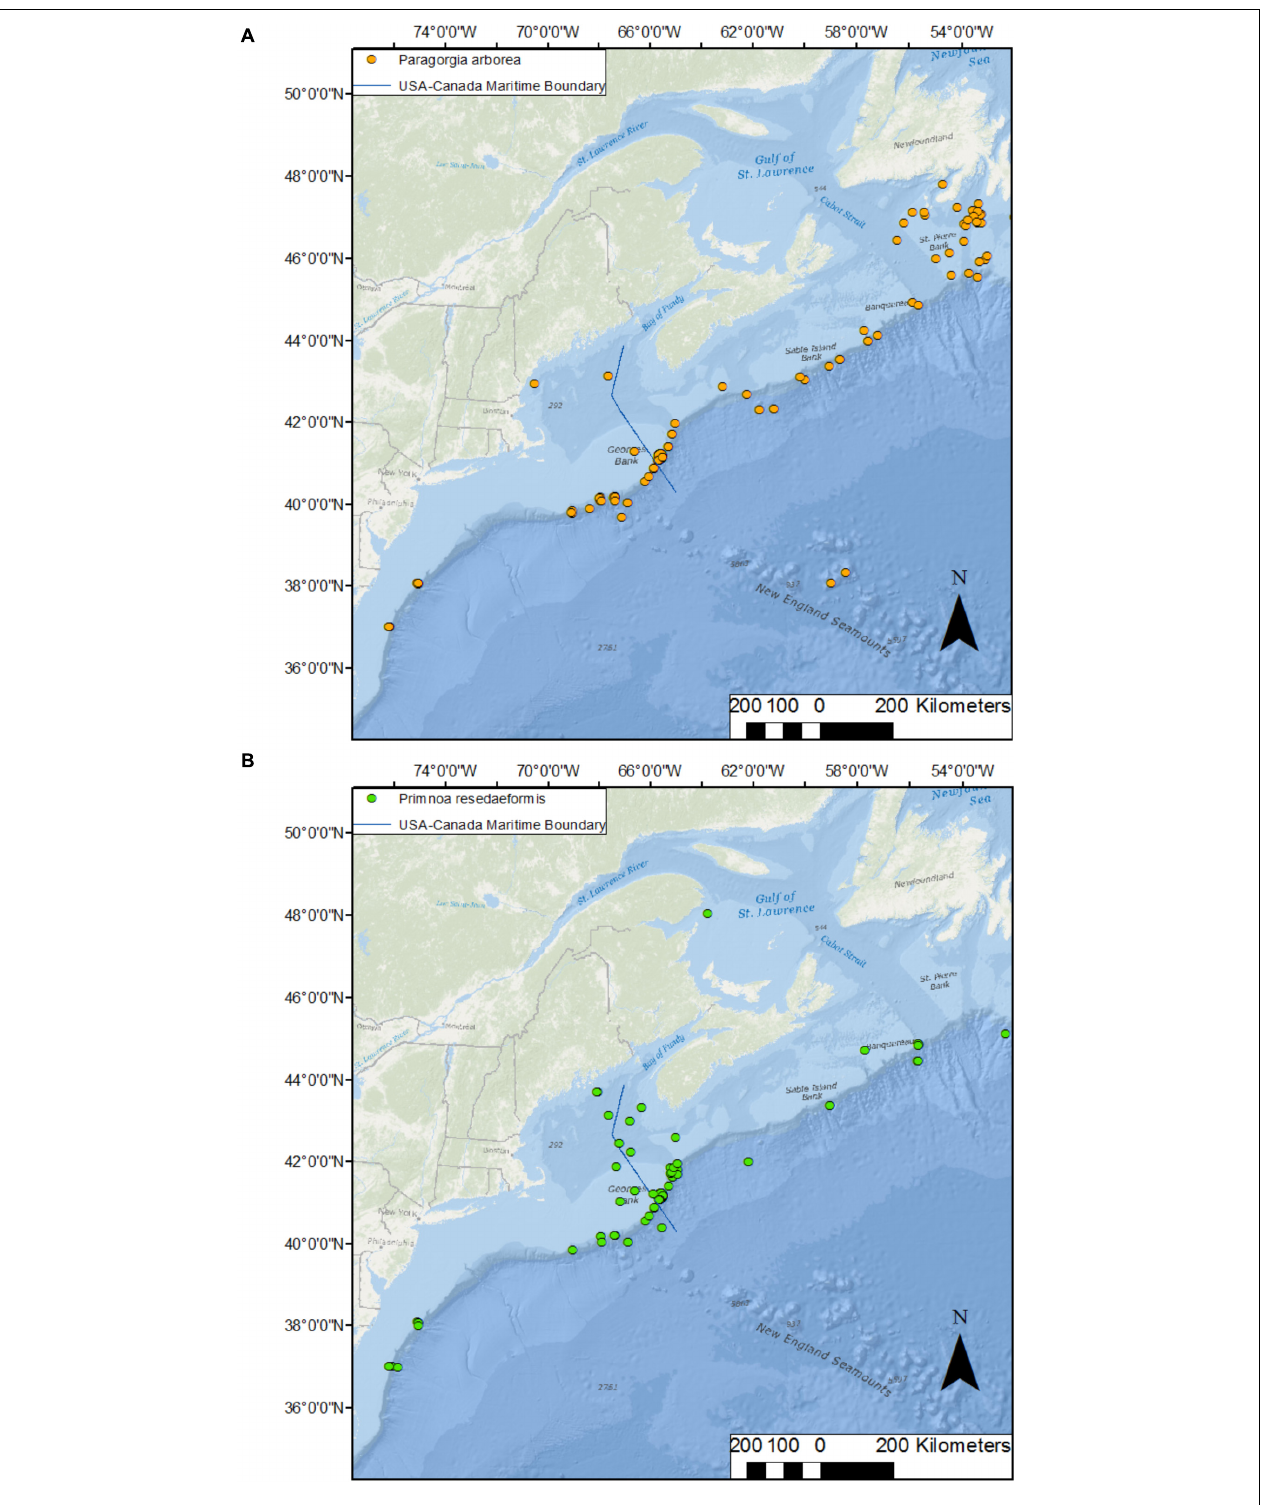
FIGURE 1 | Distribution of the deep-water corals Paragorgia arborea (A) and Primnoa resedaeformis (B) along the northwest Atlantic continental shelf break from New Jersey, United States, to Newfoundland, Canada. Data are: occurrences obtained from OBIS (http://iobis.org/), NOAA (https://deepseacoraldata.noaa.gov/), Quattrini et al. (2015), and this study; US-Canada boundary: NOAA’s Ocean Service, Office of Coast Survey (OCS); bathymetry: World Ocean Base (Esri, DeLorme, GEBCO, NOAA NGDC, and other contributors; World Ocean Reference (Esri, GEBCO, NOAA, National Geographic, DeLorme, HERE, Geonames.org, and other